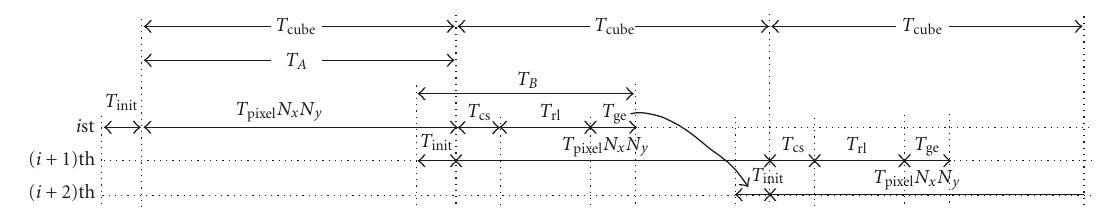
Figure 8: Illustration of timing flow in the two-stage pipeline.